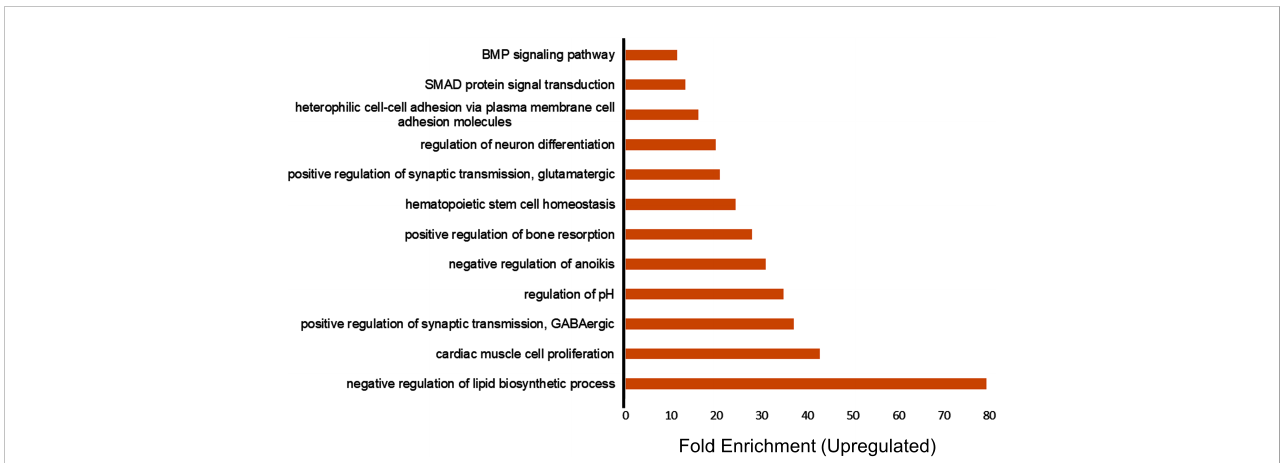
FIGURE 1 Transcriptome pro fi ling of upregulated genes in patients treated with vagus nerve stimulation. Gene ontology (GO) enrichment analysis of upregulated genes in the patients treated with VNS vs. non- treated with P value of less than 0.05 and fold change more than 2 are included in the fi gure. The bars represent the different GO categories ordered by enrichment fold change shown on the x